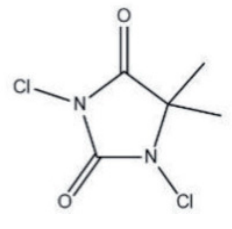
Figure 2. Molecular structure of